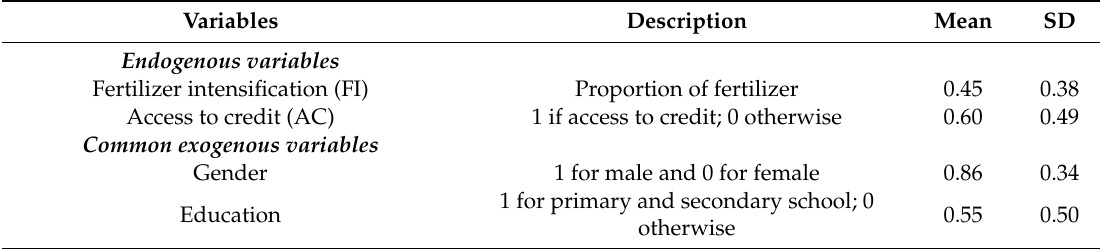
Table 1. Description of variables and the statistics’